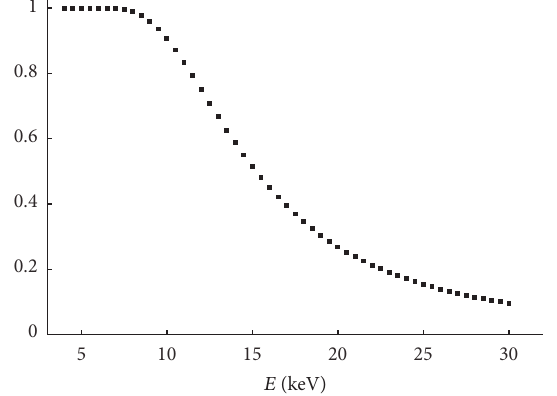
Figure 2: Relative transmission of X-ray detector onboard VZLUSAT-1 based on silicon mass attenuation